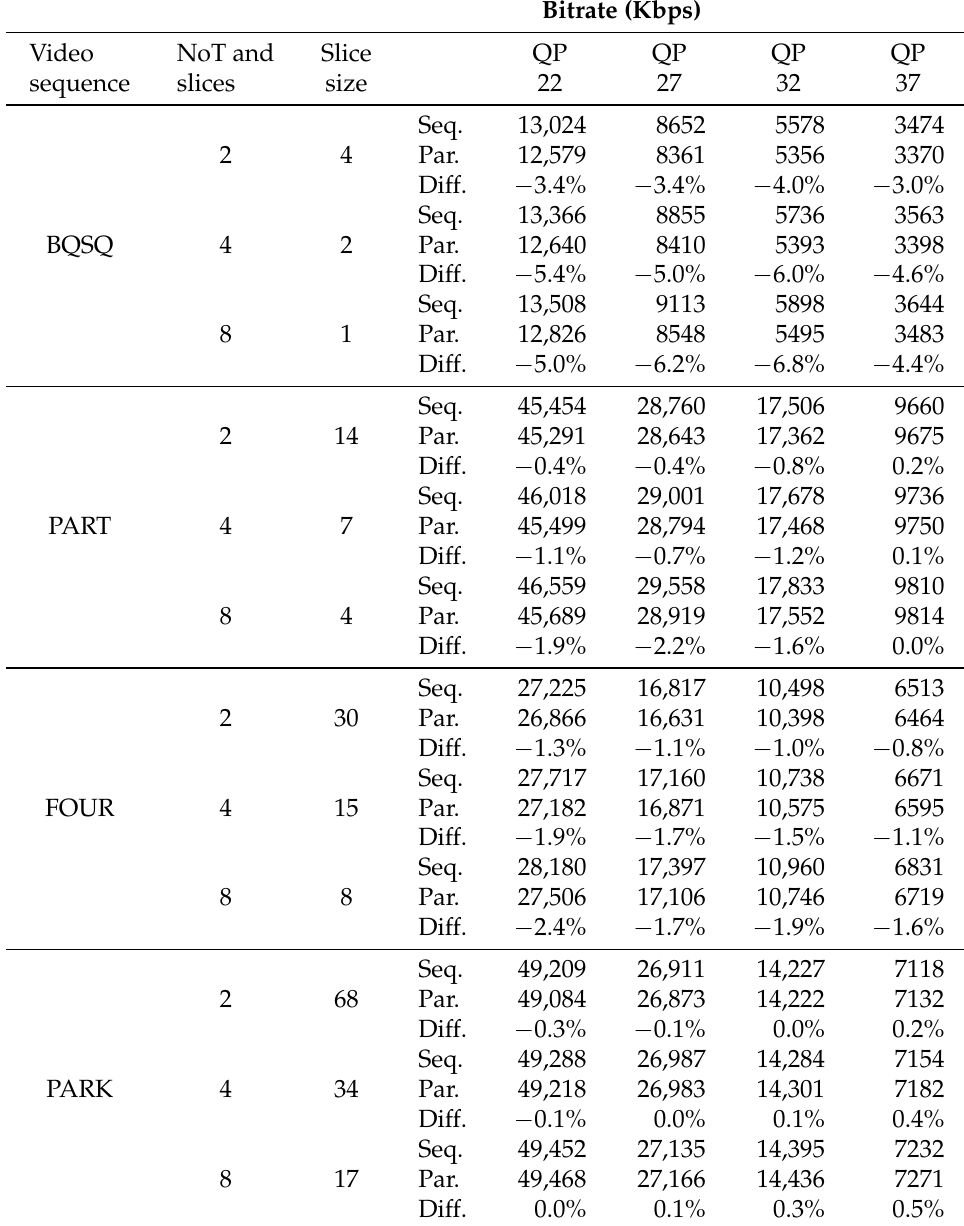
from one slice to the next, whereas in our parallel algorithms, these variables have the same initial values for all slices. Table 16. Comparison of